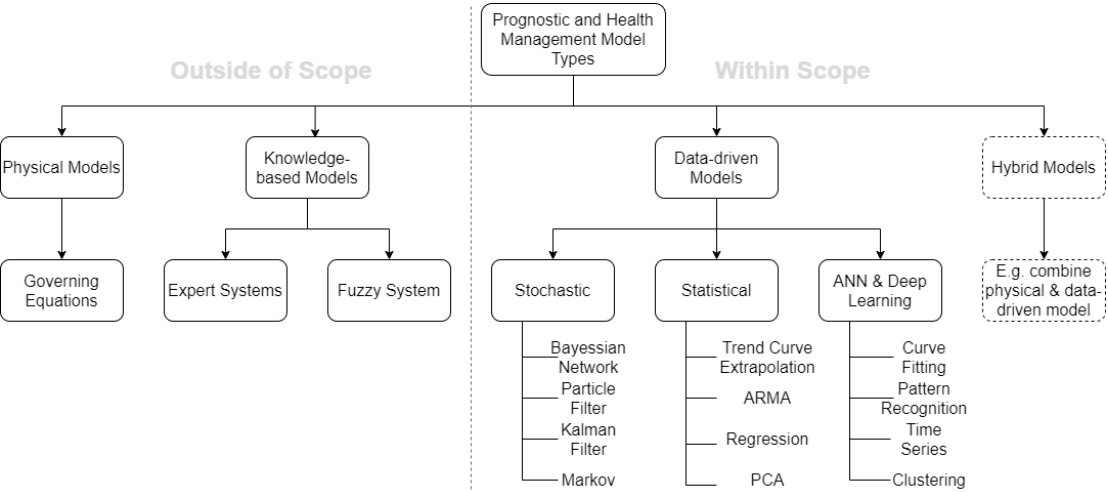
Figure 2. A representation of model types that can be developed and utilised within the PdM field.